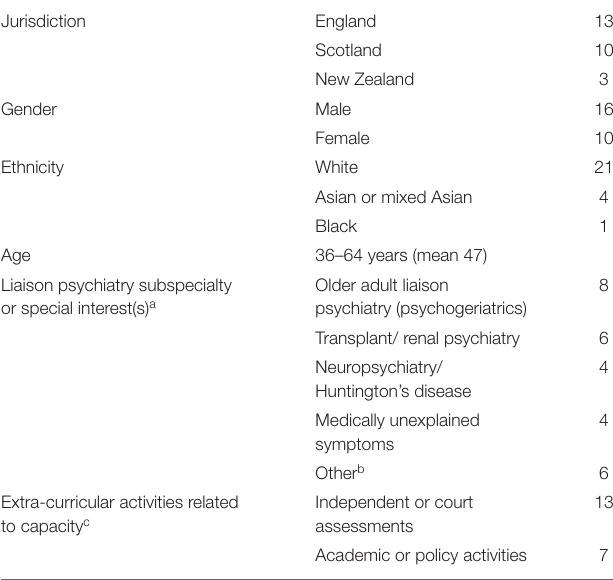
TABLE 1 | Characteristics of Liaison psychiatrist